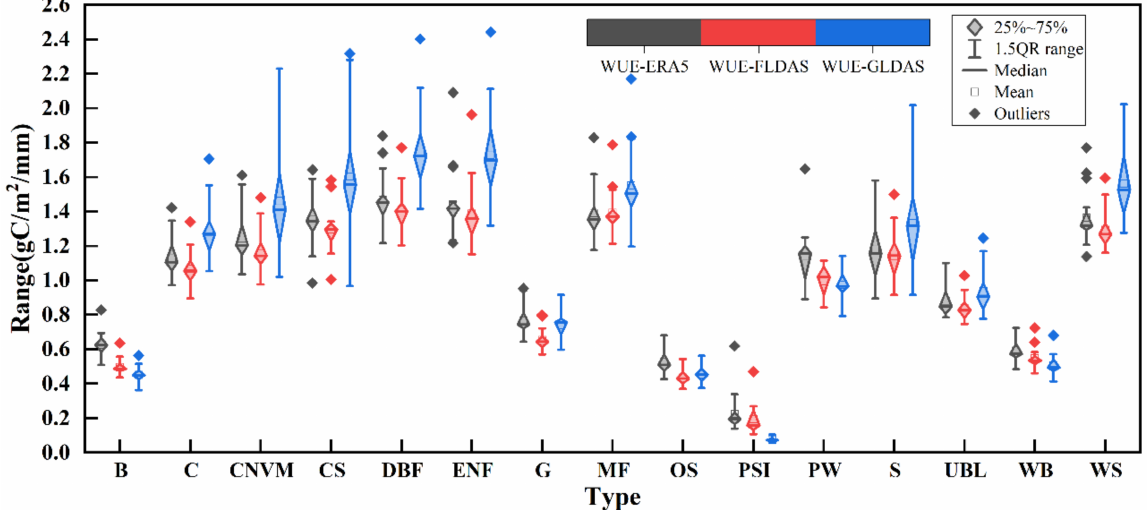
Figure 9. Box plots of the annual mean WUE values in different land-use types in the